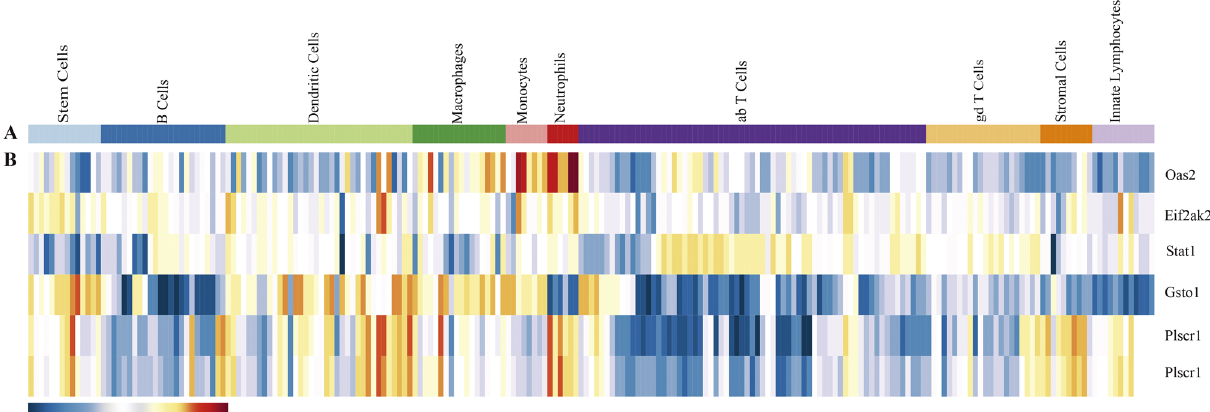
Fig 2. Overview of Gene Expression for the Common Marker Genes in Various Immune Cell Subsets. (A)The different bar colors represent different immune cell subsets. (B) The bar under the heatmap illustrates that the expression level increases gradually with the color changing from blue to red. The gene expression data was extracted from the ImmGen (available at http://www.immgen.org/). Two datasets were included in the ImmGen for the PLSCR1 gene. The Fig was processed on Dec 9, 2015.